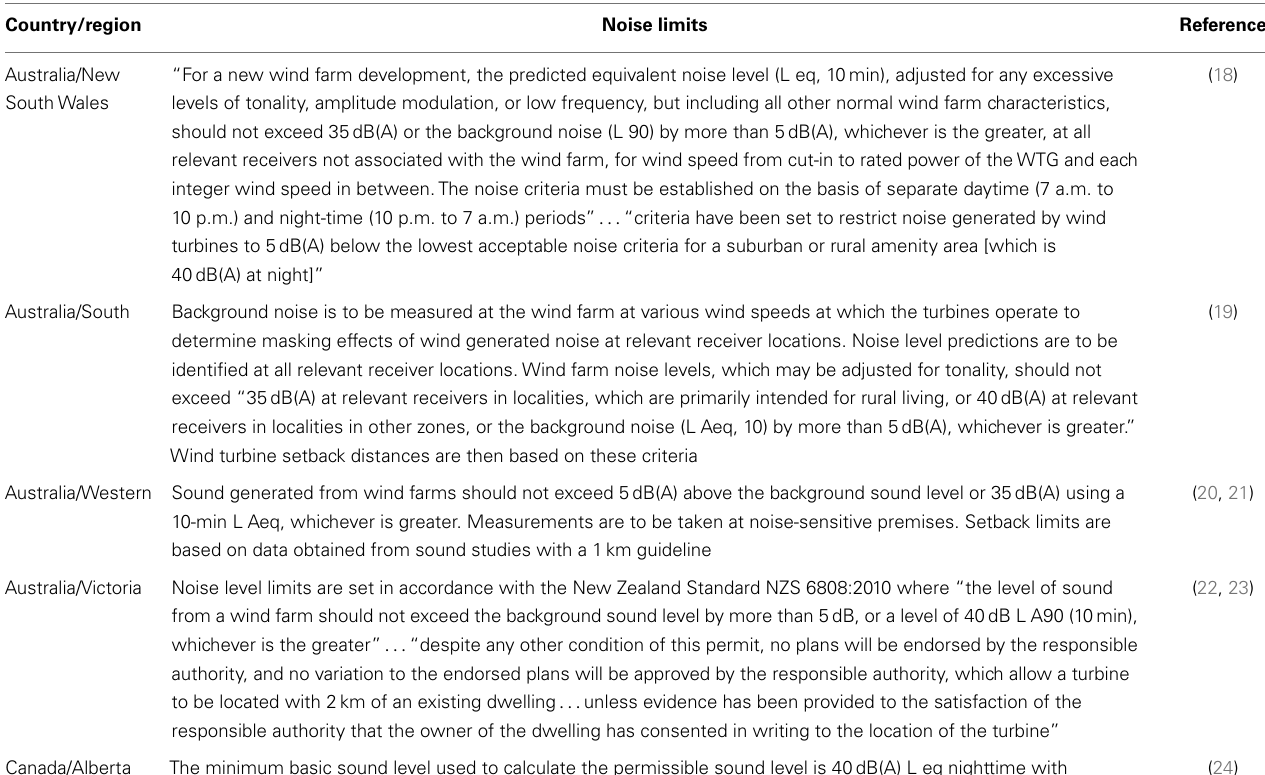
Table 1 | Current or proposed wind turbine noise limits per jurisdiction